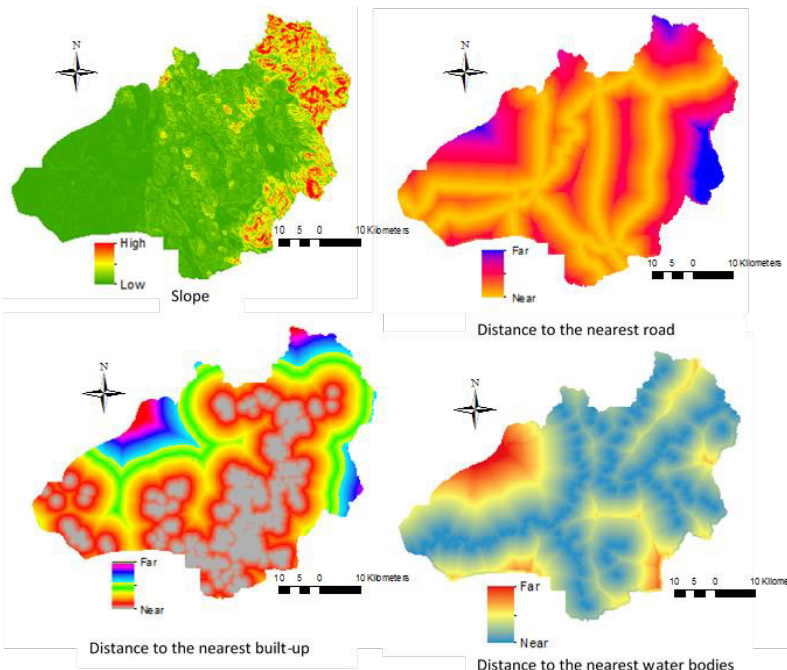
Fig. 4: The drivers of land use change used for AHP and fuzzy